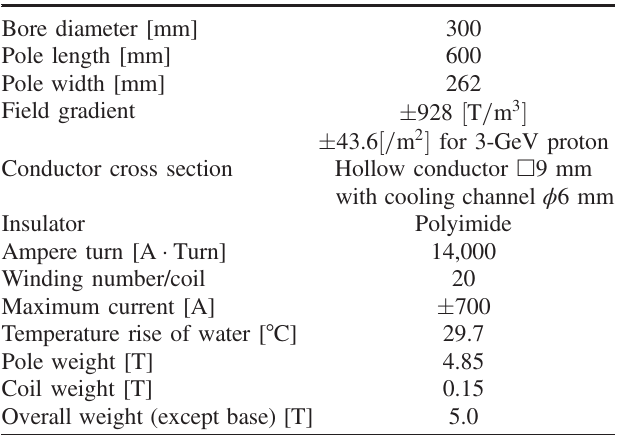
TABLE I. Parameters of fabricated octupole magnet for non- linear optics.